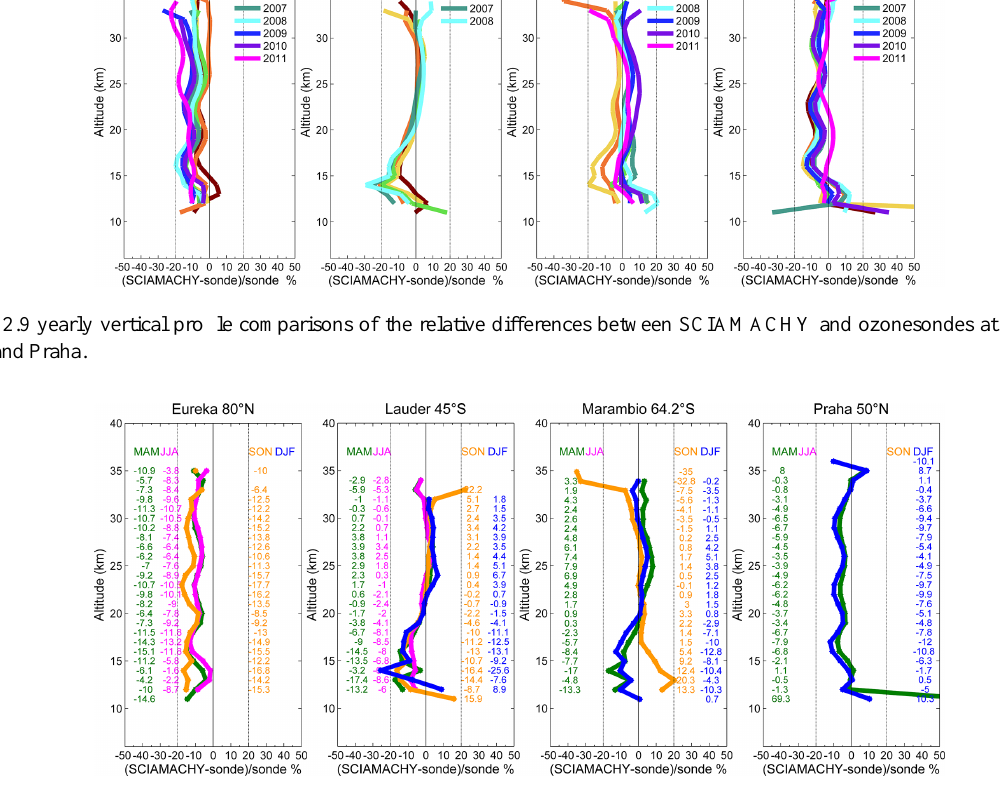
Figure 5. V2.9 seasonal vertical profile comparisons of the relative differences between SCIAMACHY and ozonesondes from 2003 to 2011 at Eureka, Lauder, Marambio and Praha. No/not enough corresponding measurements in DJF for Eureka, in JJA for Marambio, and in JJA and SON for